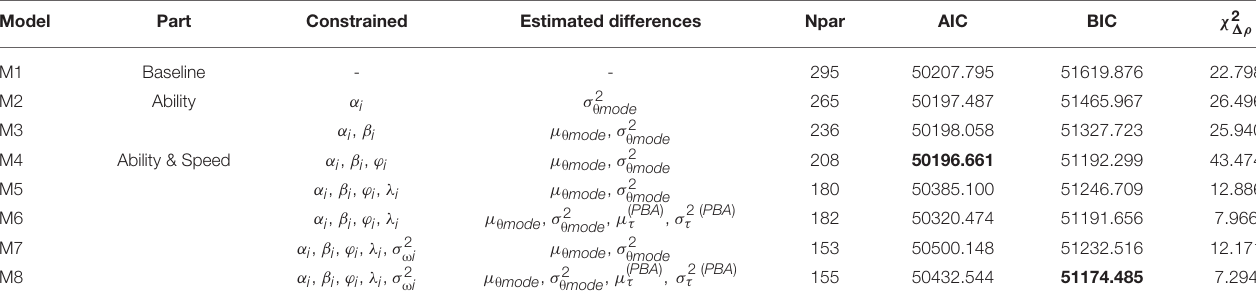
TABLE 5 | Measurement invariance of the B-GLIRT model with linear interaction term in the cross-relation function between computer-based and paper-based assessment.